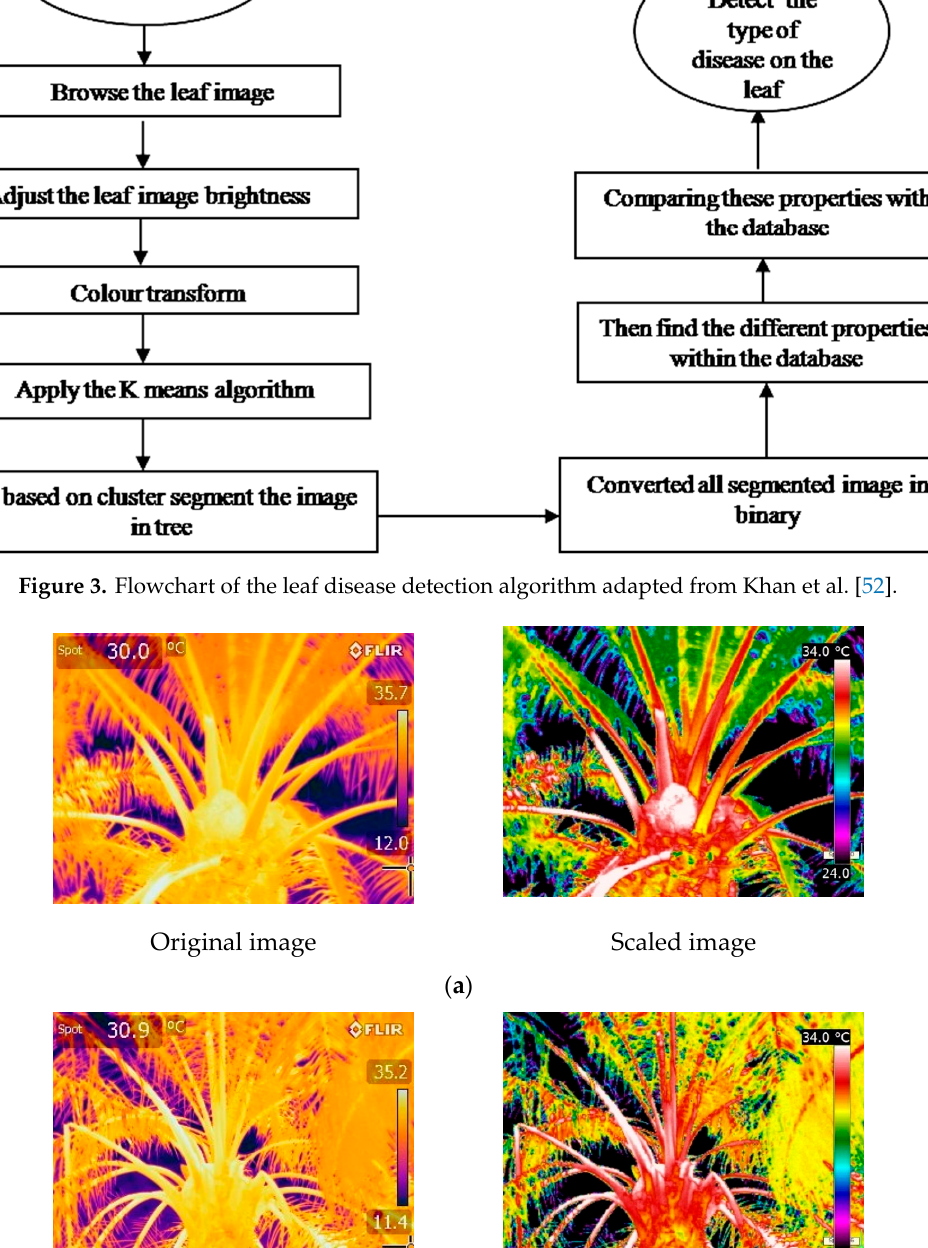
Figure 3. Flowchart of the leaf disease detection algorithm adapted from Khan et al. [52].